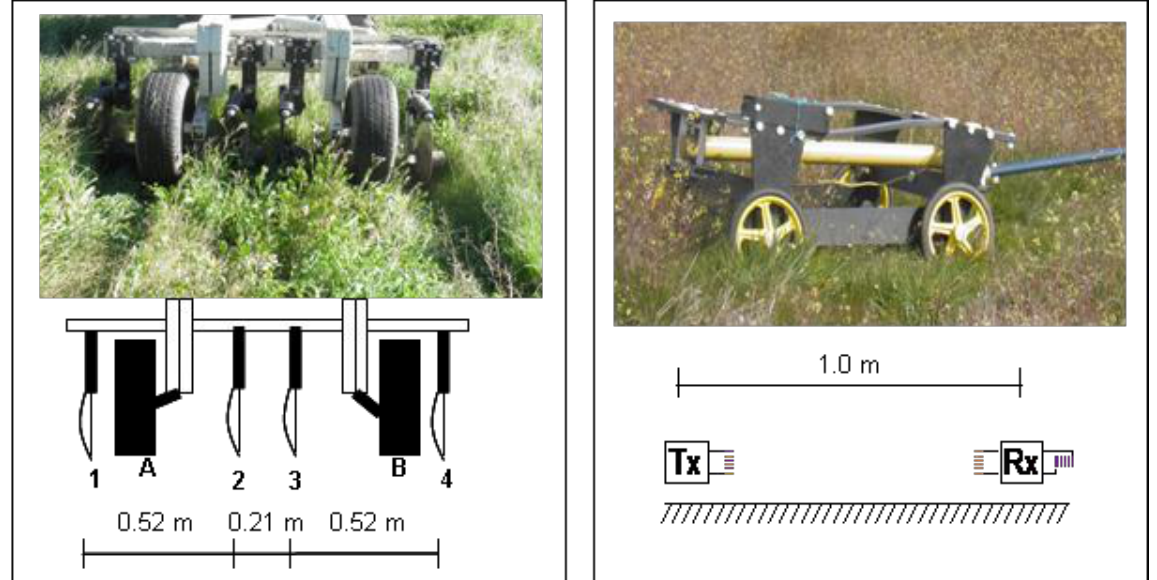
Figure 1. Above: survey with Veris 2000 XA ( left ) and DUALEM 1S ( right ) sensors in the experimental field (February 2012); bottom: geometry of Veris 2000 XA (left; A and B are wheels and 1–4 are rotating discs or coulter-electrodes) and DUALEM 1S sensor (right: Tx is the transmitter and Rx the two